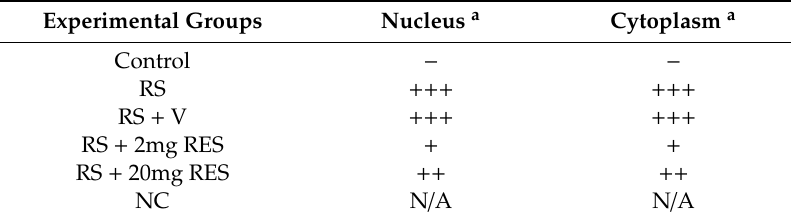
Table 1. Relative levels of immunostaining for AIF antibody in the nucleus and cytoplasm of parietal cells.